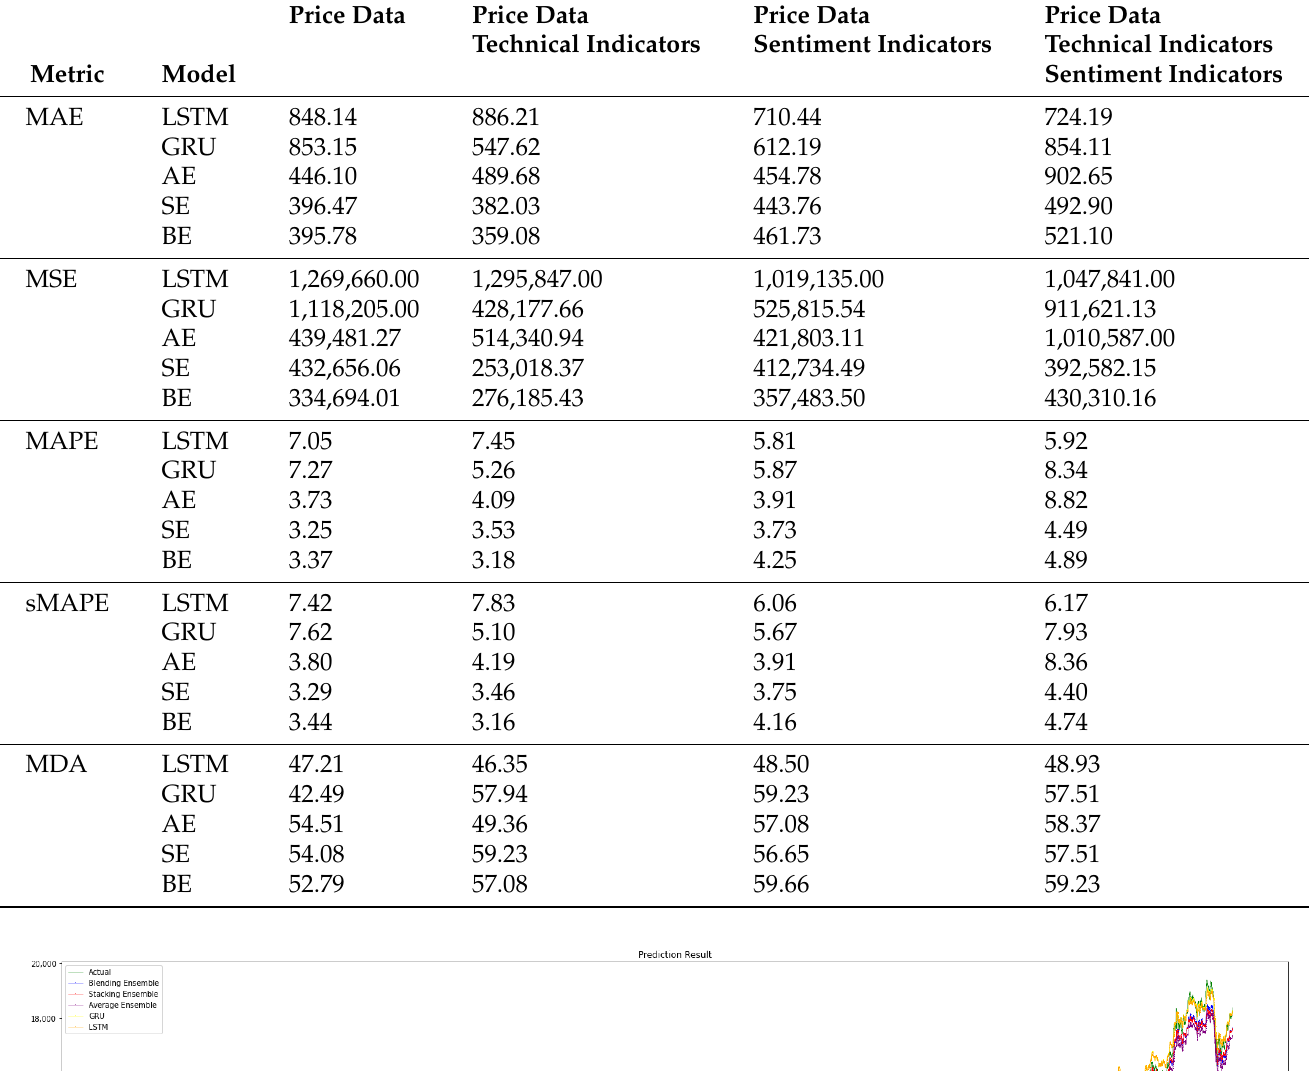
Table 5. Results of 1-day intervals.